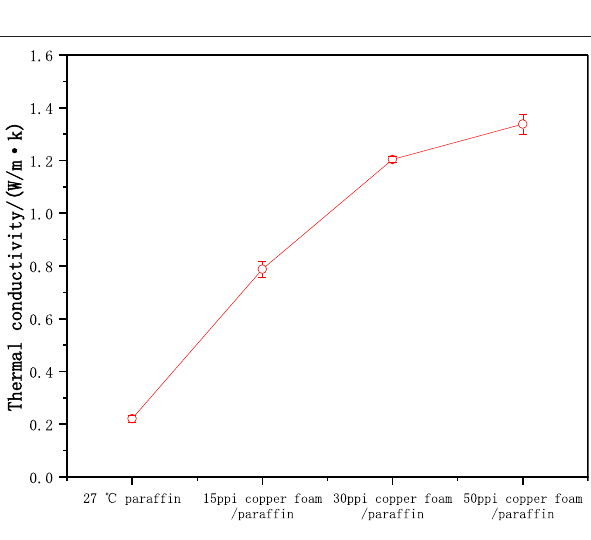
FIGURE 5 | Thermal conductivity enhancement PCM